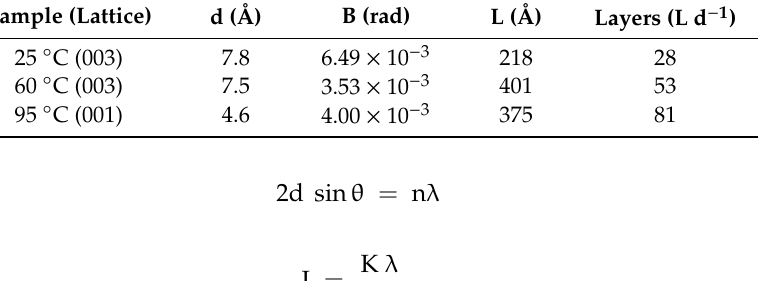
Figure 4. The microstructure of as-deposited Co(OH) 2 at different temperatures.